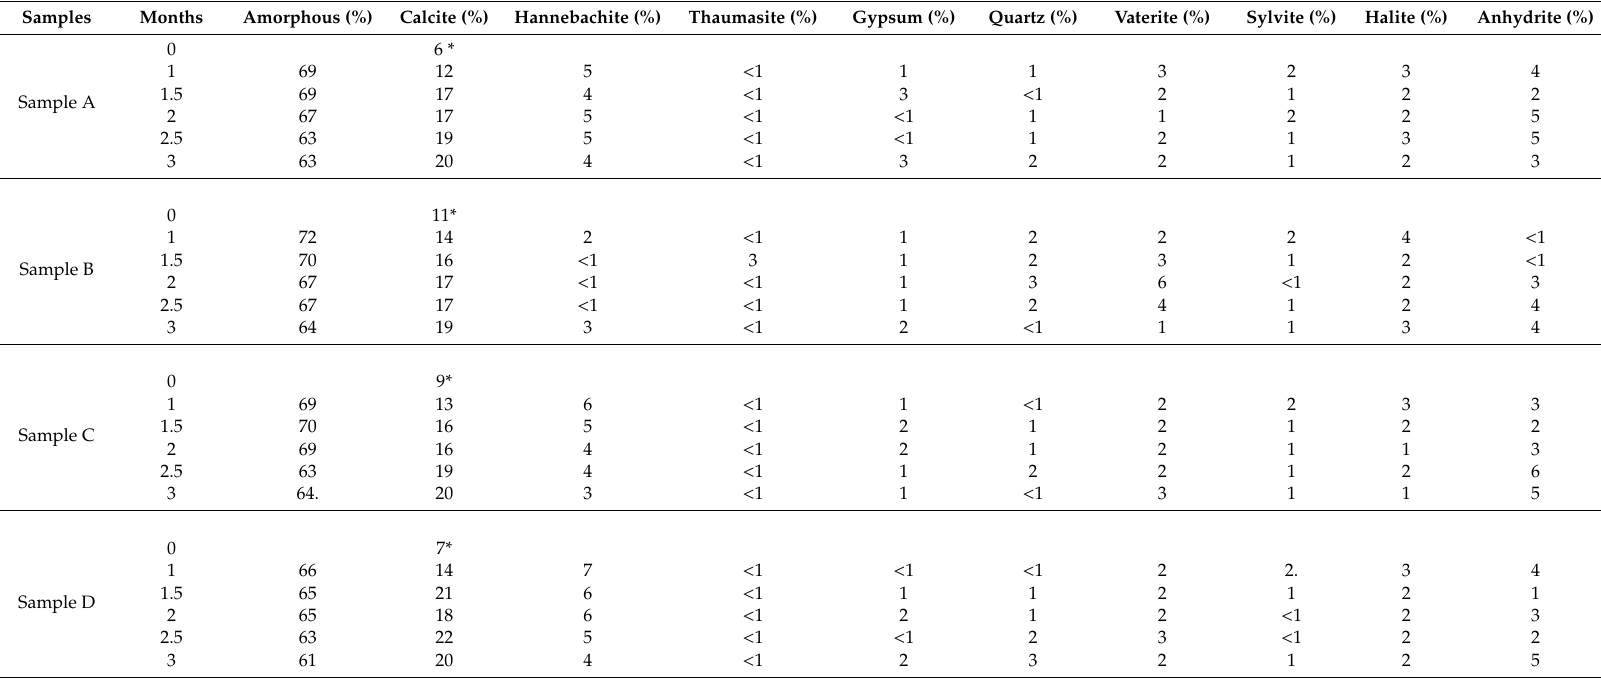
Table 3. Results of Rietveld analysis at di ff erent aging times (semi-quantitative